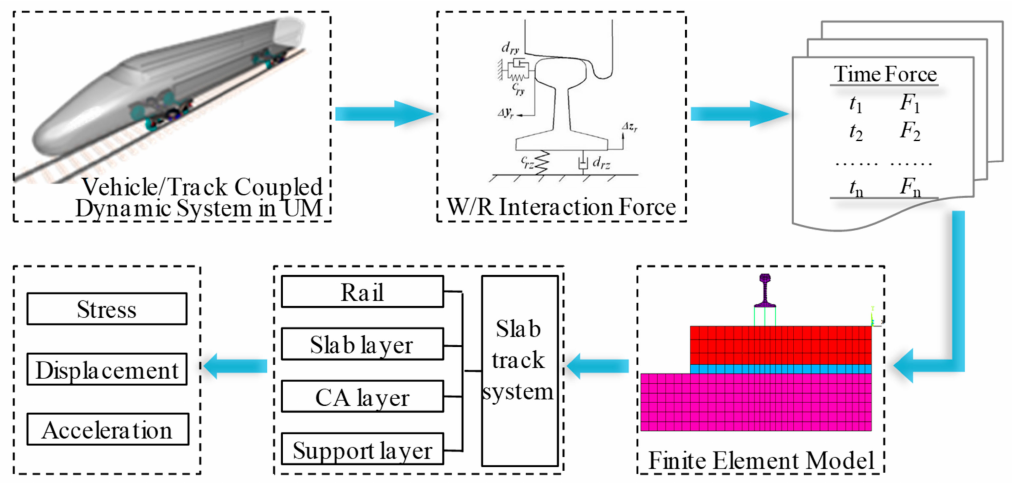
Figure 2. Diagram of modeling